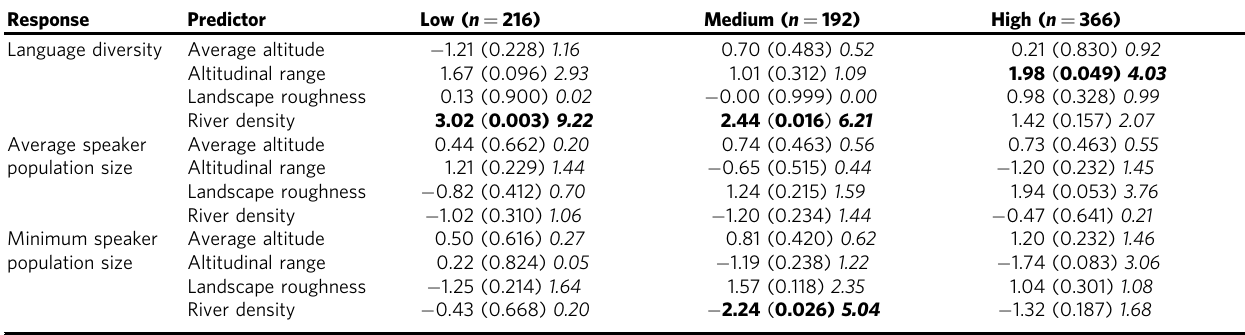
Table 3 Landscape effects on language diversity and speaker population